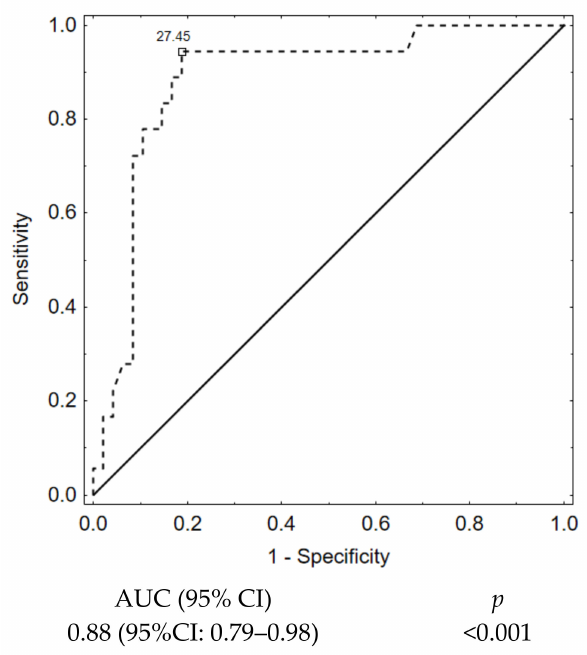
Figure 6. Packing density ROC